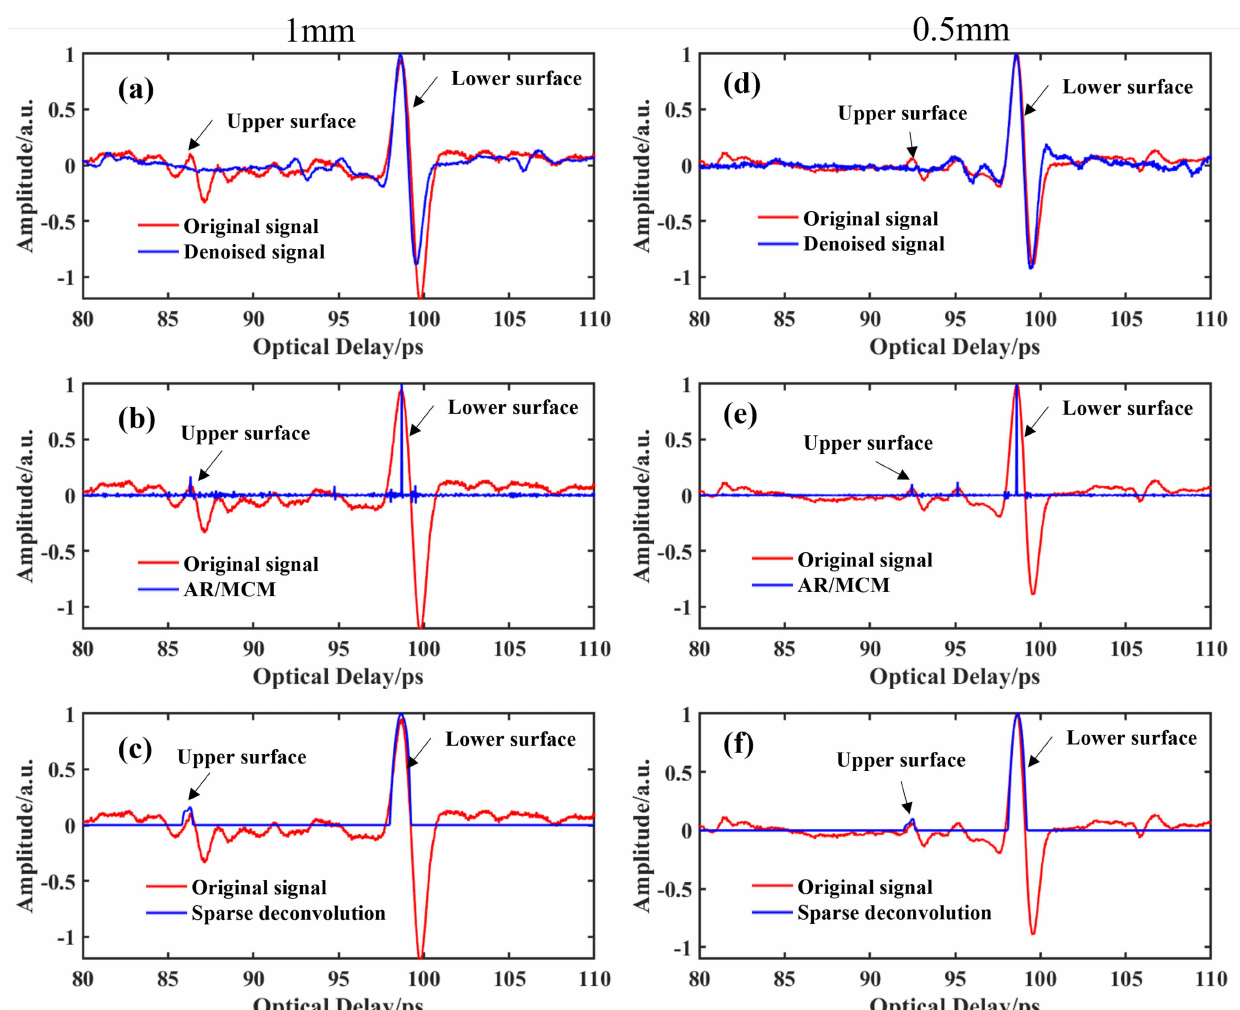
Figure 7. The results obtained by the different methods for the samples with different thicknesses of glue: ( a – c ) 1 mm; ( d – f ) 0.5